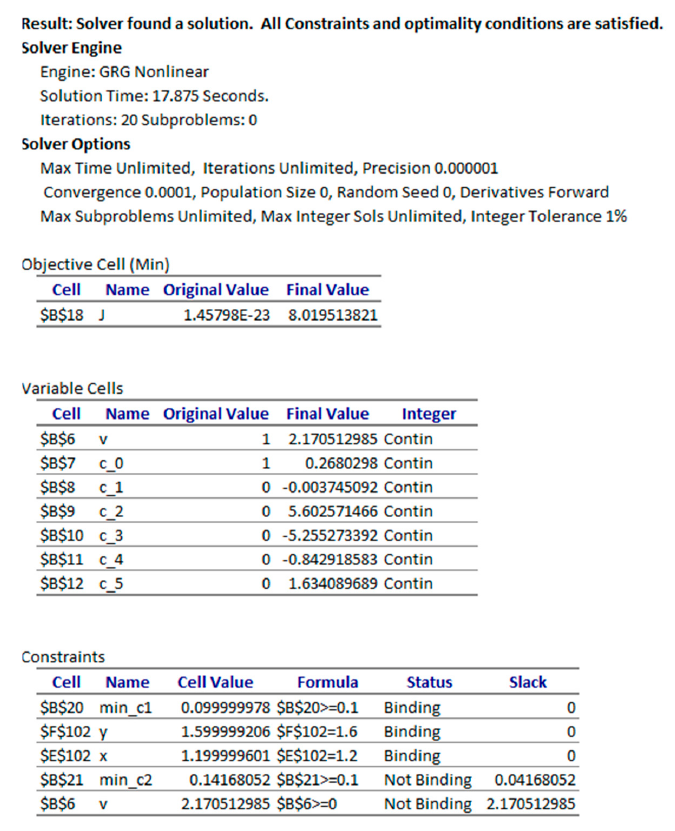
Figure 17. Answer report generated by Excel Solver for problem 3.3.